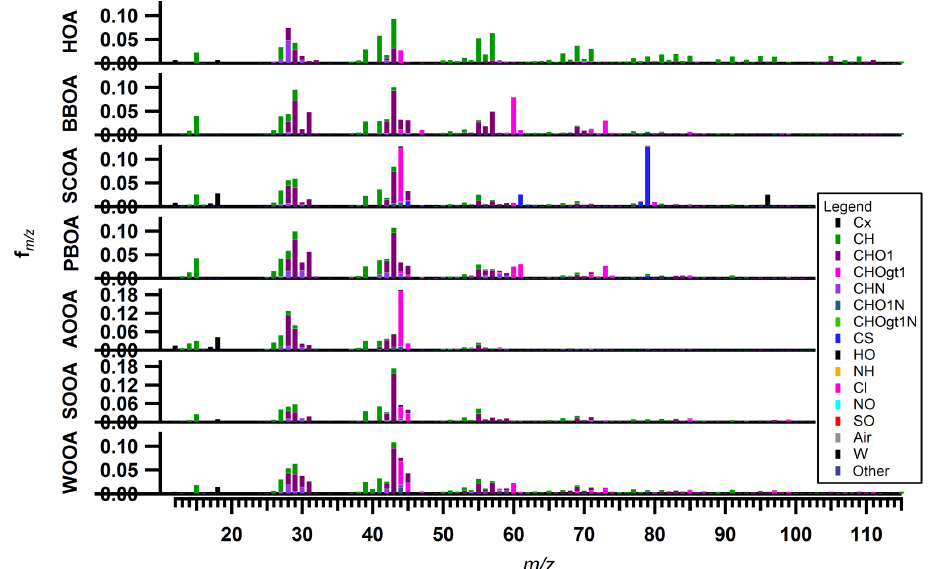
Figure 5. Offline AMS/PMF (ME-2) factor profiles: hydrocarbon-like OA (HOA), biomass burning OA (BBOA), sulfur-containing OA (SCOA), primary biological OA (PBOA), anthropogenic oxygenated OA (AOOA), summer oxygenated OA (SOOA) and winter oxygenated OA